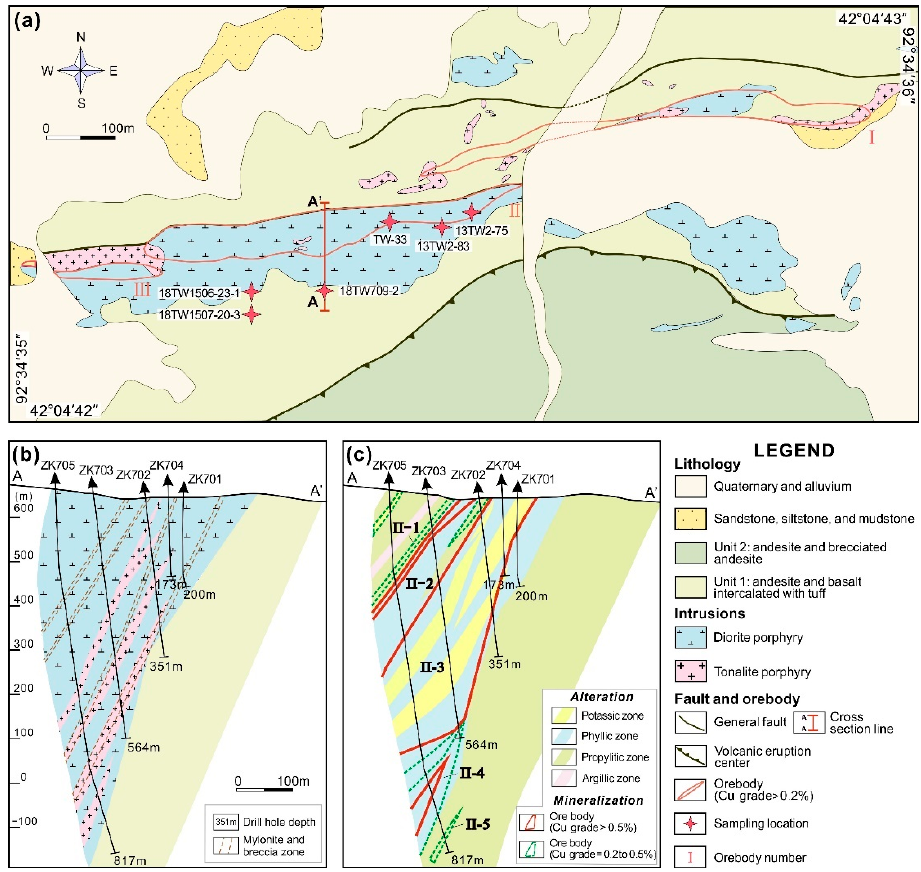
Figure 2. ( a ) Geological map of the Tuwu porphyry Cu deposit (modified from [28]); ( b ) geologic cross section A-A’ looking north showing lithology, and ( c ) geological cross section A-A’ with alteration and mineralization.